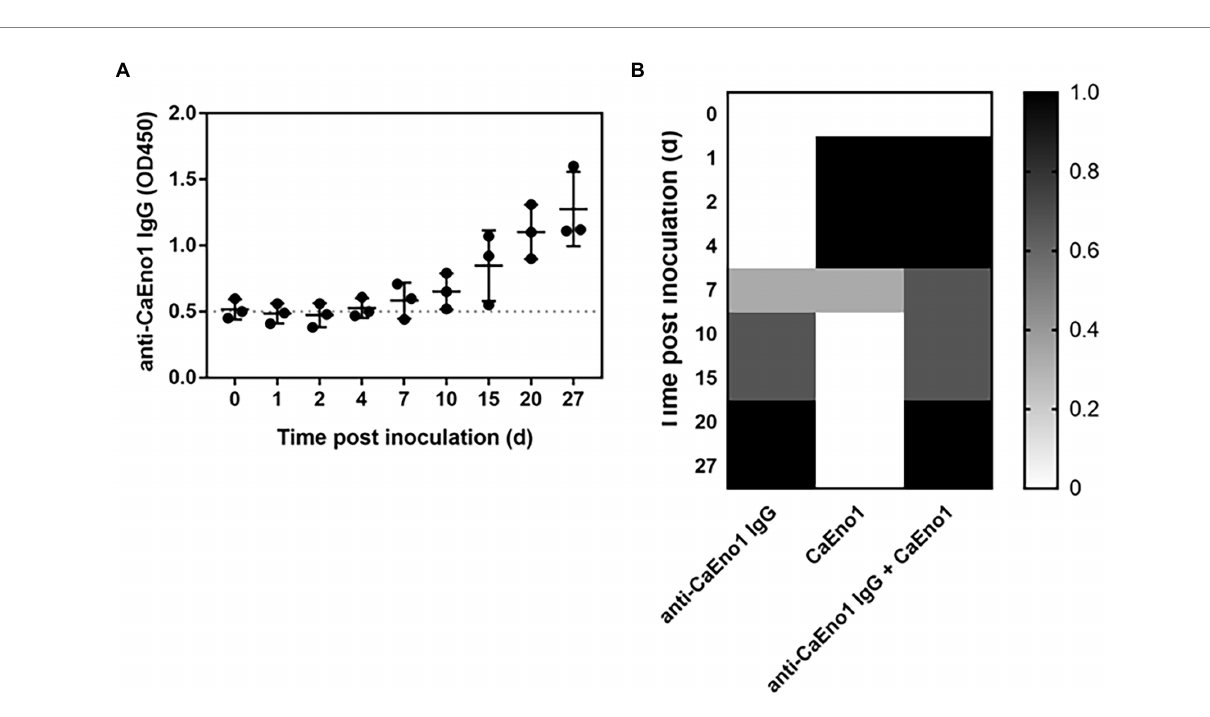
FIGURE 5 Combined CaEno1 antigen–antibody detection enhanced diagnostic efficiency in rabbits inoculated with C.albicans . (A) Anti-CaEno1 IgG dynamics in rabbit plasma; (B) Diagnostic efficiency of anti-CaEno1 IgG, CaEno1 detection, and their combined